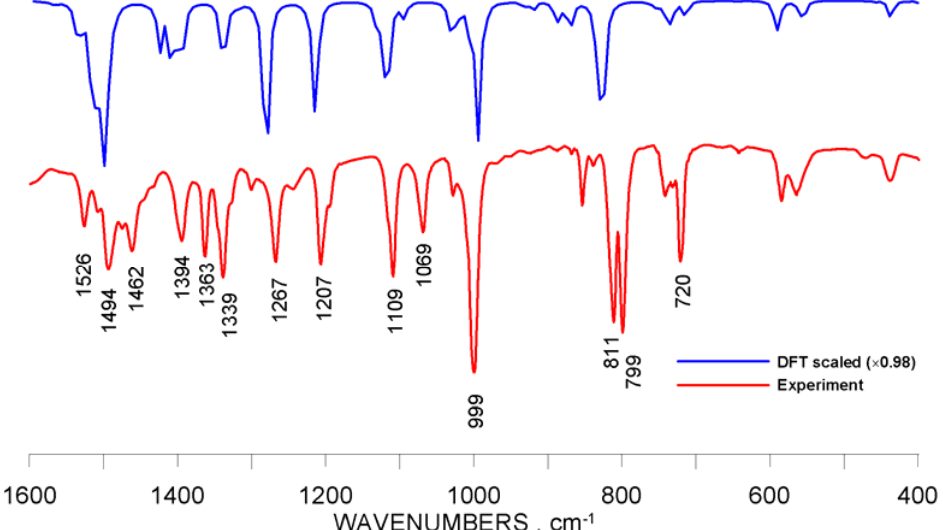
Figure 4. Experimental FTIR spectrum of ZnTBPP and the simulated IR spectrum obtained from DFT